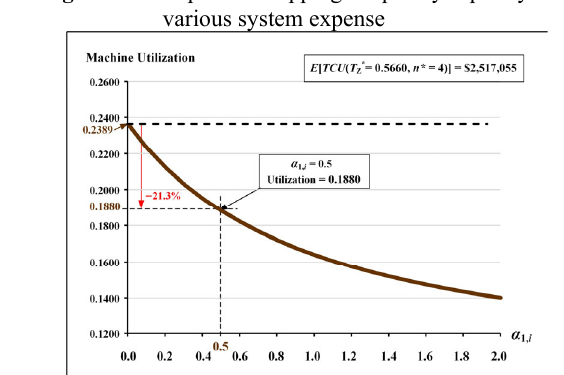
Fig. 6. E [ TCU ( T Z , n )]’s behavior vis-à-vis n and T Z Fig. 7. The impact of shipping frequency n per cycle on